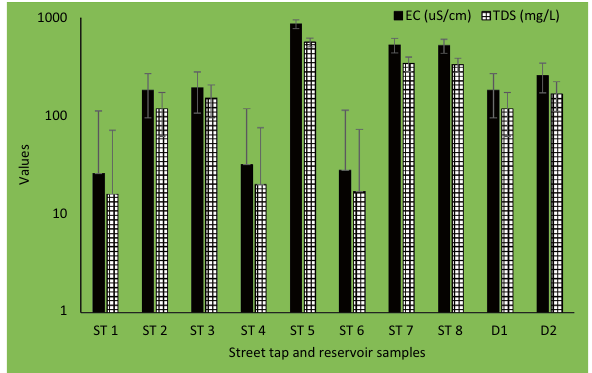
Figure 3. EC and TDS levels for the street taps and reservoir samples.